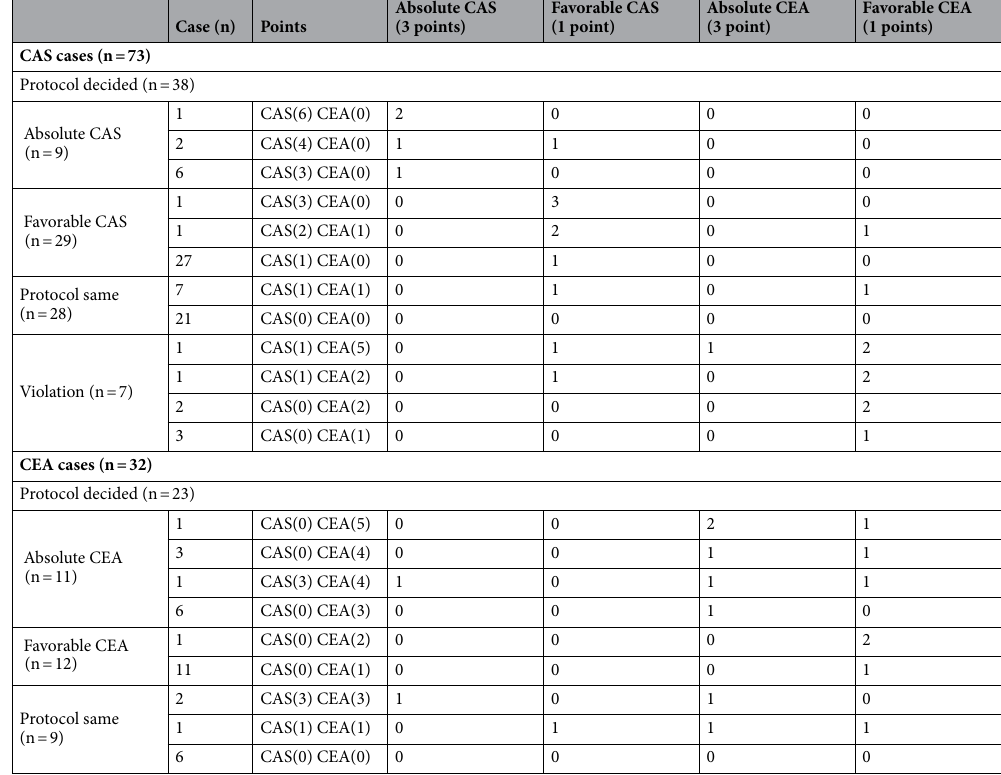
Table 3. Number of cases according to points from the protocol. CAS carotid artery stenting, CEA carotid